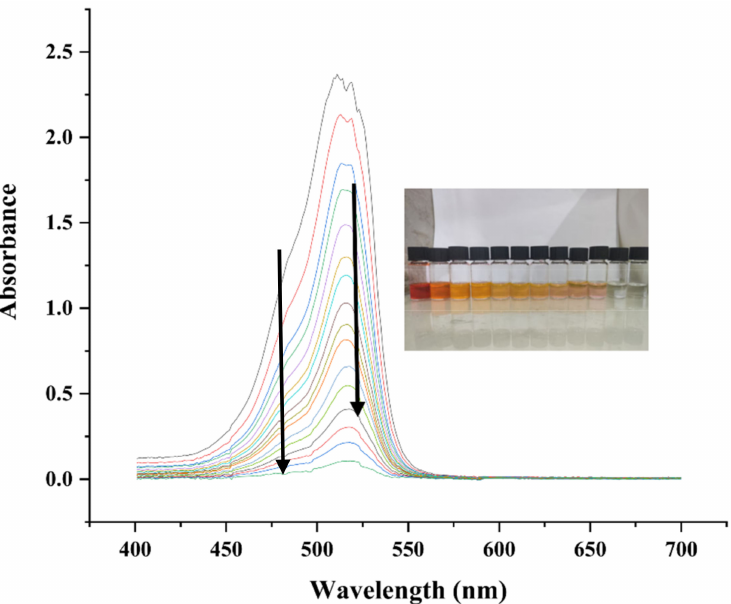
Figure 20. Series of spectra showing the degradation of EY against silver nanoparticles taken after each 4 min for an hour.